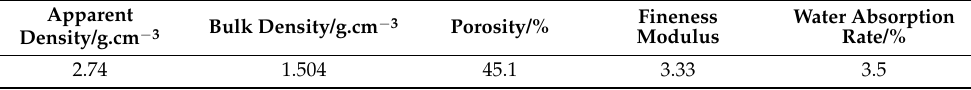
Table 6. Physical and mechanical properties of crushed stone fine aggregate